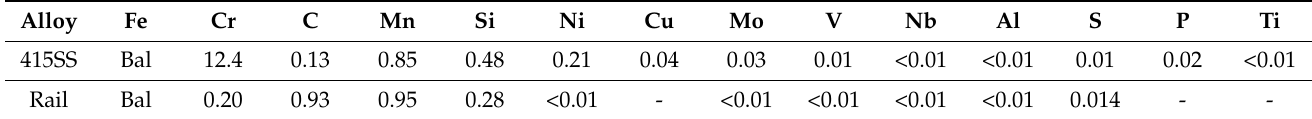
Table 1. Chemical composition of the 415SS cladding and hypereutectoid substrate in weight per- cent (wt%).